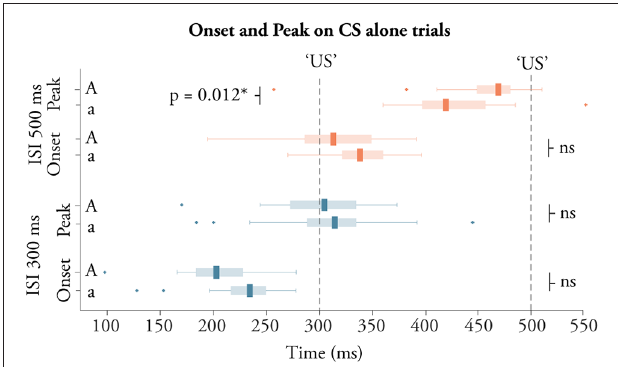
FIGURE 3 | CR timing. Boxplots illustrating the timing of the onset and peak of conditioned responses elicited during training with a 500 ms ISI (red boxes) and 300 ms (blue boxes), for adolescents (bottom box in each pair) and adults (top box in each